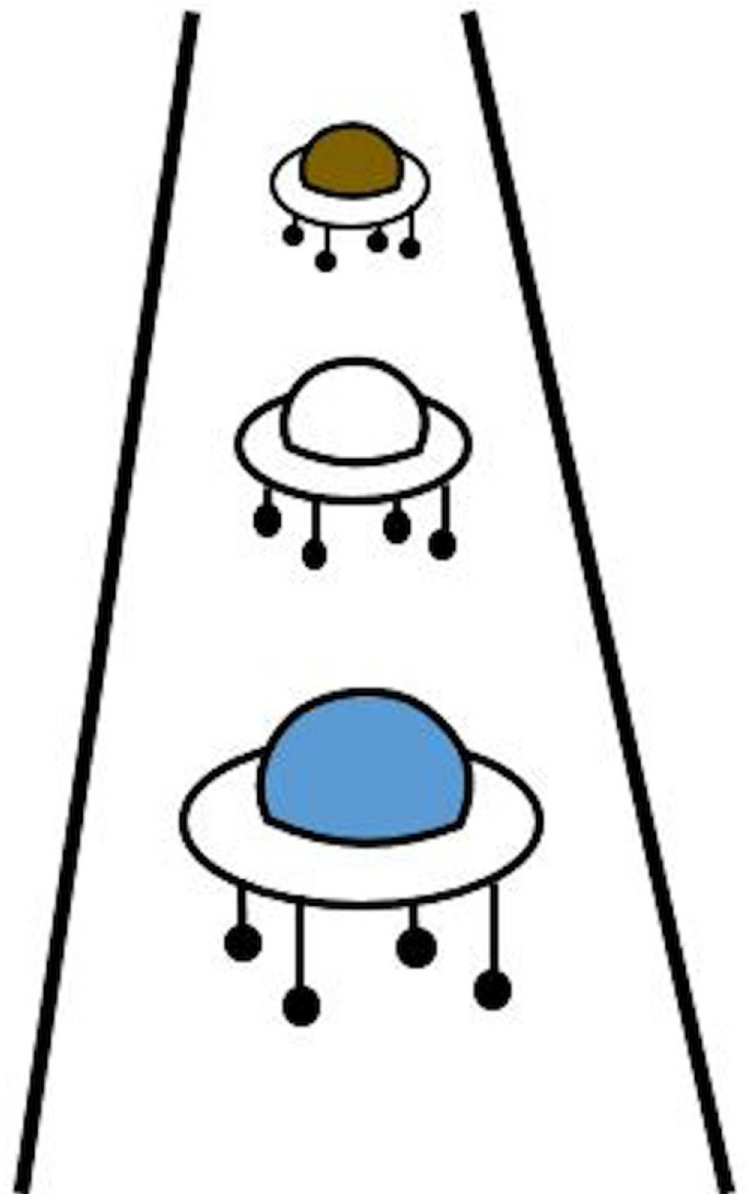
Fig 1. The ambiguous spatial target. Participants were invited to answer the question:“Which one of these widgets is ahead?”(picture adaptedfrom Boroditsky [8]) by naminga color. The answer “blue” (near) is congruent to an ego-moving reference frame, whereasthe answer “brown” (far) is congruentto an object- moving reference frame.